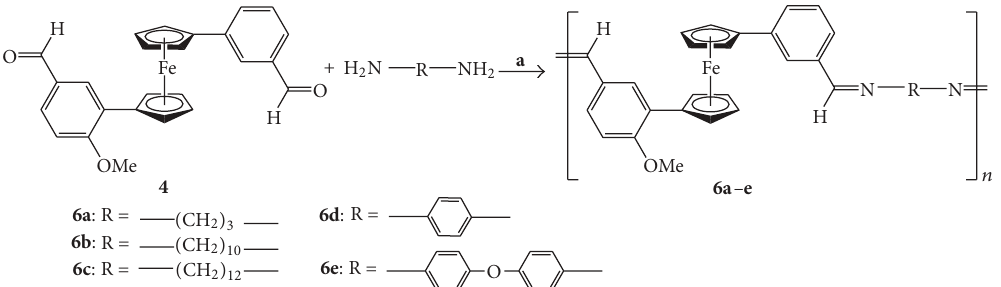
Figure 1: H-NMR spectrum of model compound 5 in CDCl 1